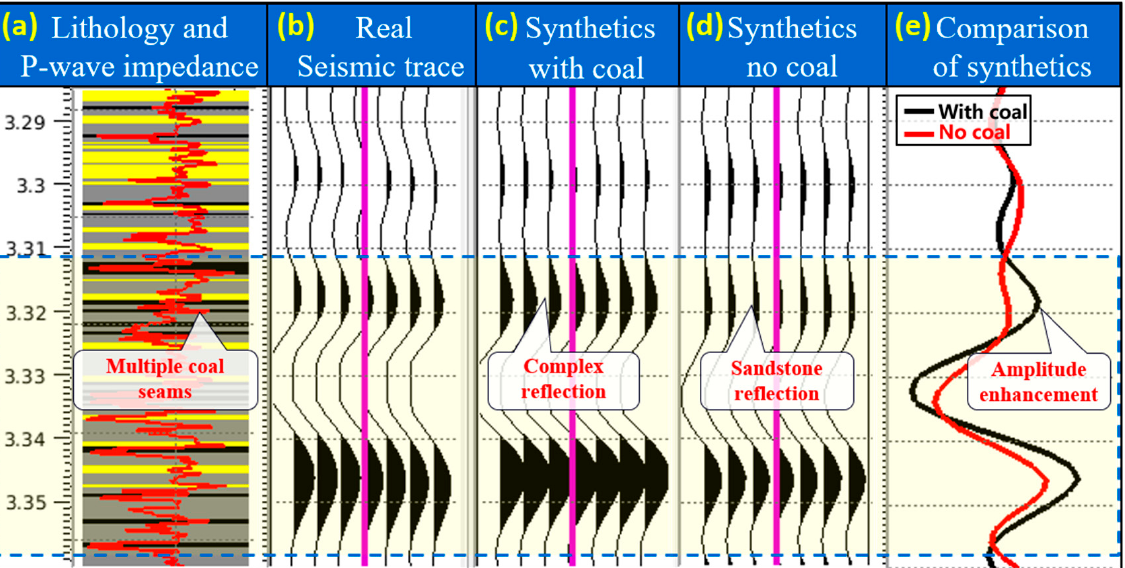
Figure 16. Lithologic results of well logs and comparison of seismic records: ( a ) lithology and P-wave impedance, ( b ) real seismic trace, ( c ) synthetics with coal, ( d ) synthetics without coal, and ( e ) comparison of synthetics.